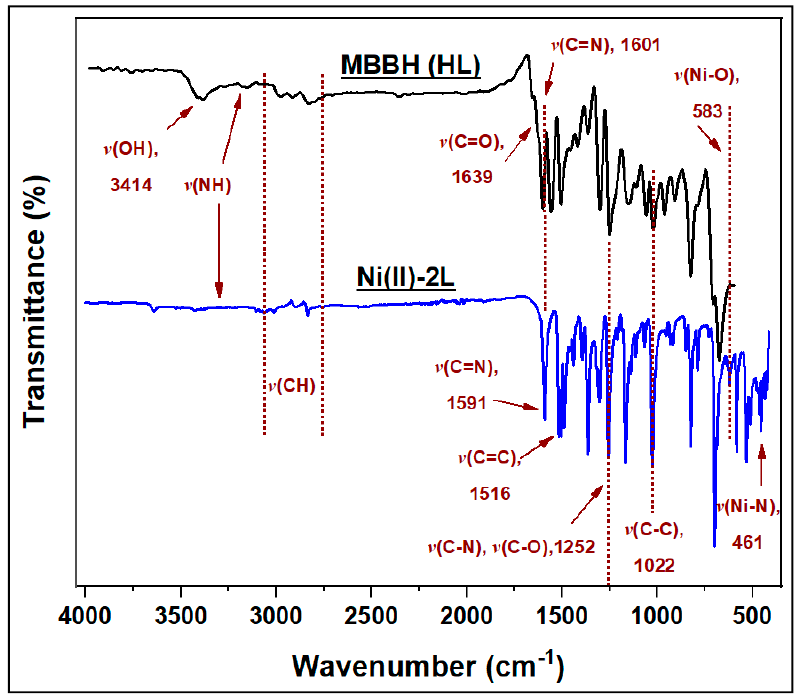
Figure 2. Fourier transform infrared spectra of the N ′ -(4-methoxybenzylidene)benzohydrazide (HL) ligand and its nickel(II) complex (Ni(II)-2L).